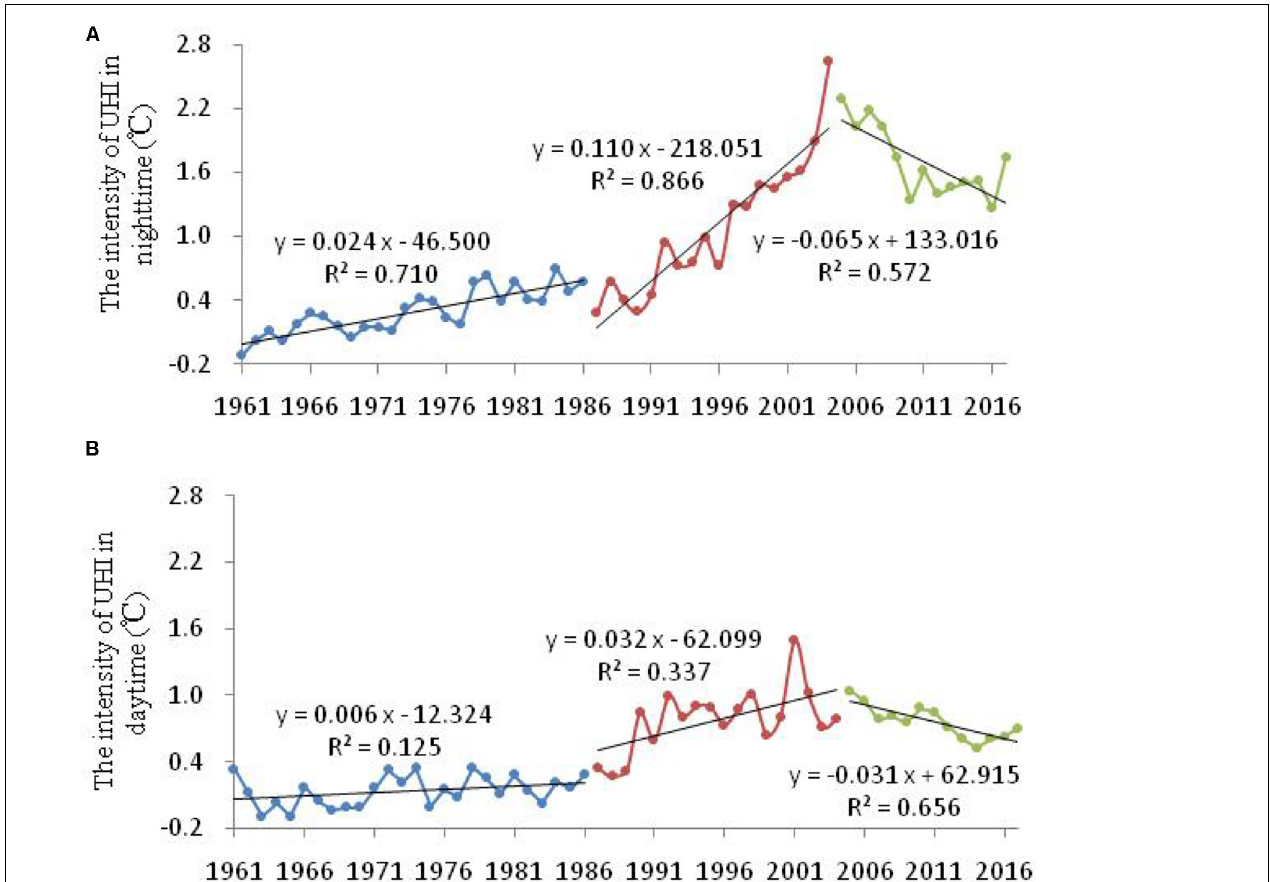
FIGURE 5 | The annual mean UHI intensity in nighttime (A) and daytime (B) in Shanghai from 1961 to 2017.